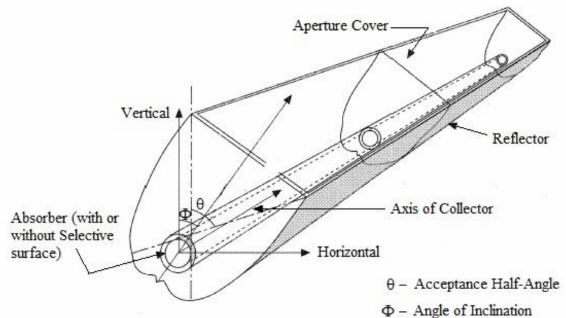
Figure 9. Compound Parabolic